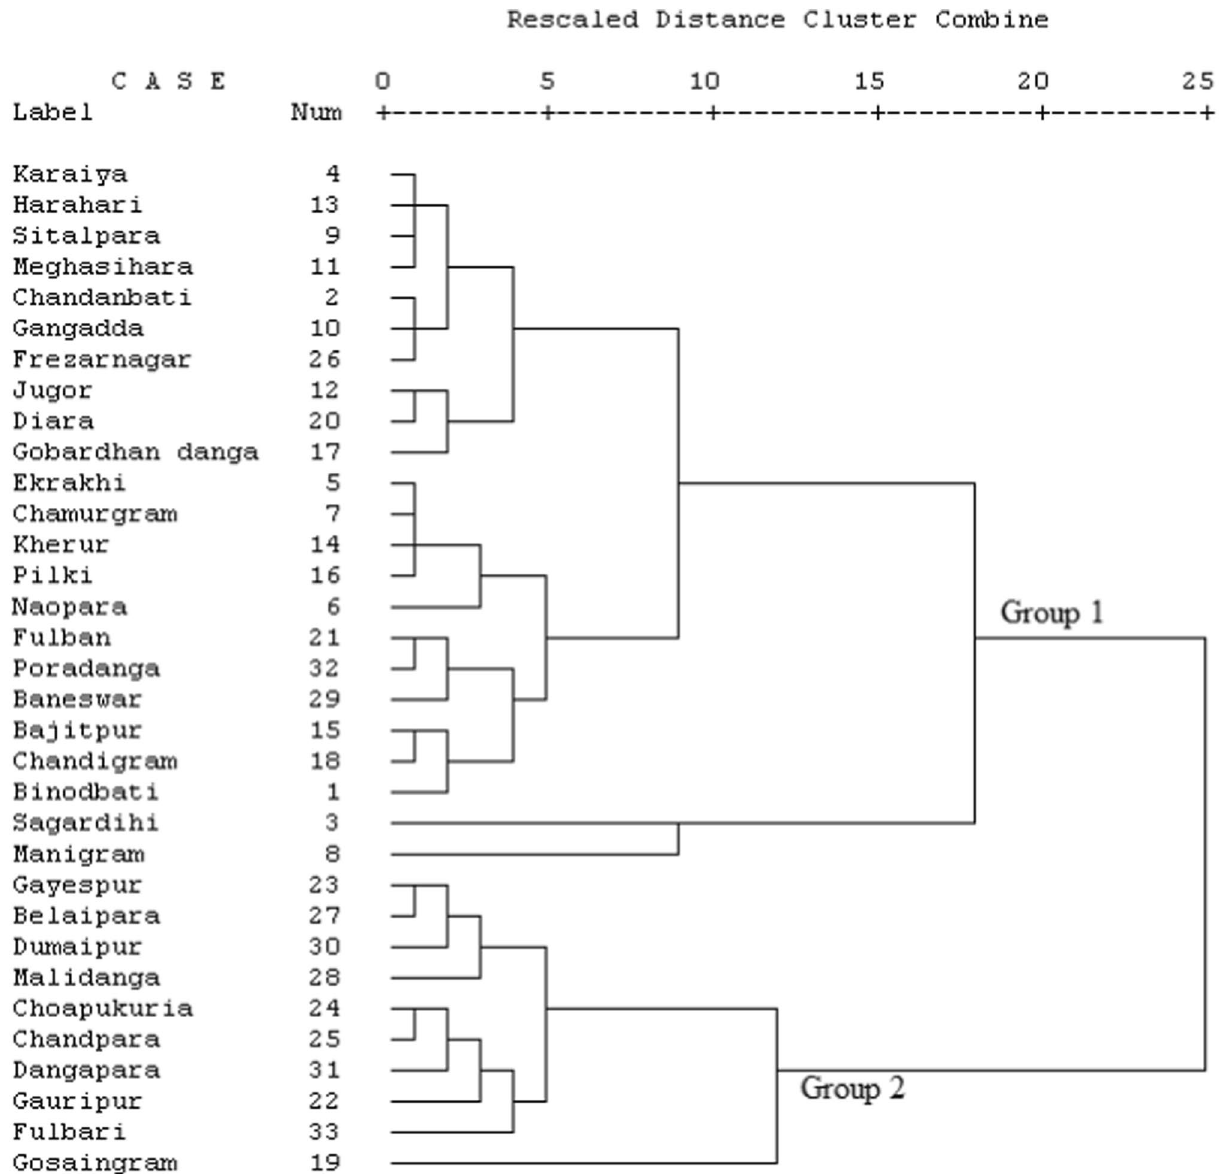
Fig. 7 Dendrogram showing cluster of variables